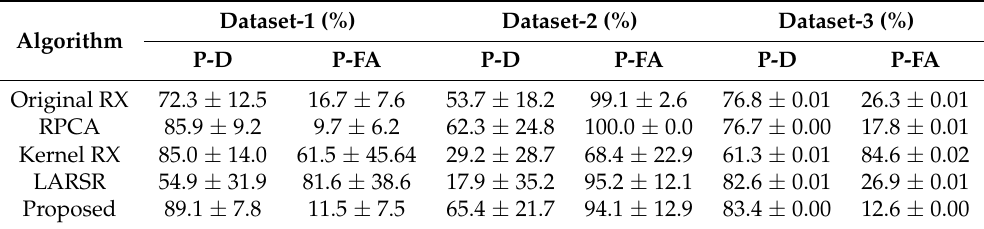
Table 5. Anomaly detection results on three datasets. (P-D at P-FA = 0.01, P-FA at P-D = 1).